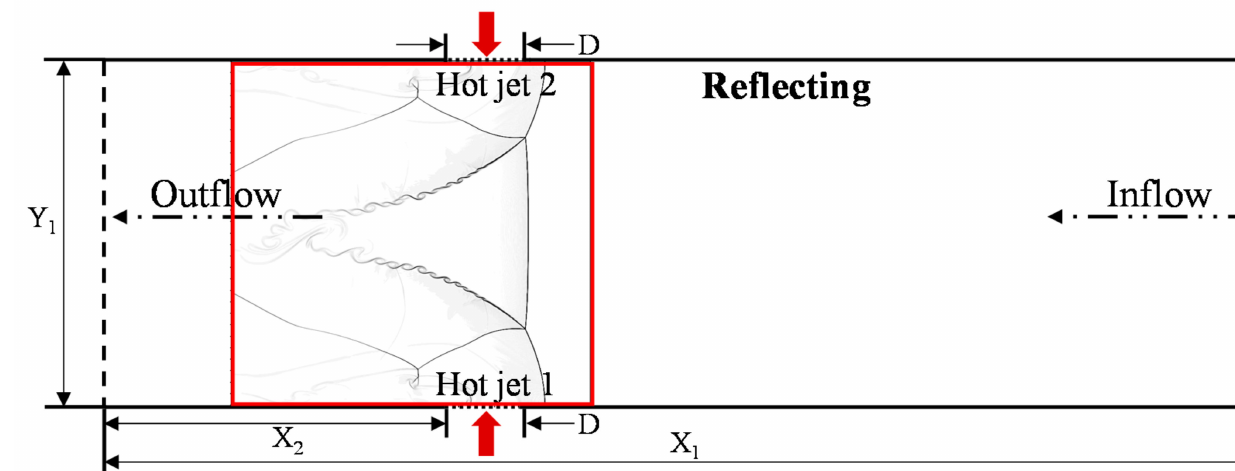
Figure 1. Schematic illustration of calculation